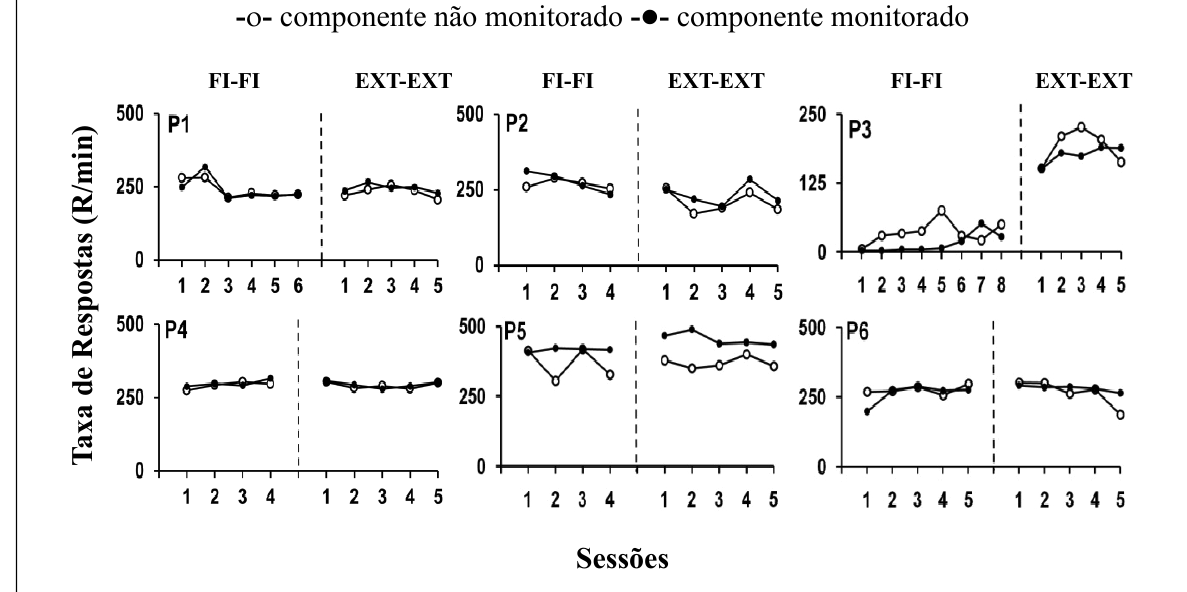
Figura 1 . Taxas de respostas (R/min) no componente monitorado (círculos cheios) e não monitorado (círculos vazios) em cada uma das sessões. A linha tracejada na vertical representa a mudança de fase do experimento. O eixo y do P3 é diferente dos outros participantes pois obteve taxas de respostas